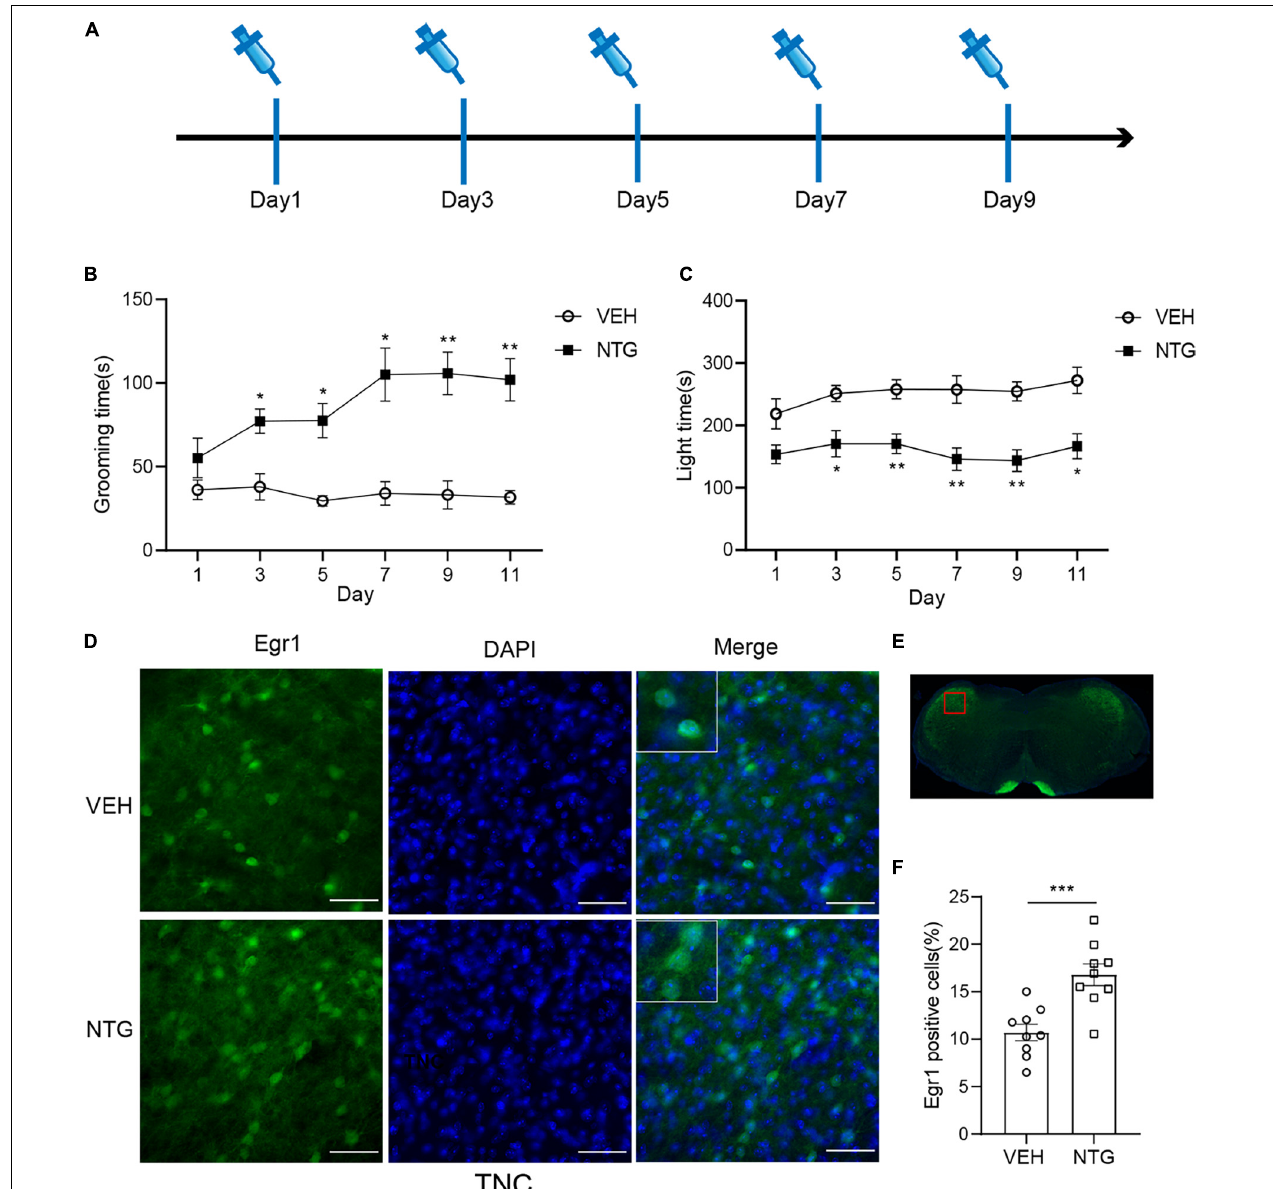
FIGURE 1 | Repeated NTG injection induced migraine related behaviors and elevation of Egr1 expression in TNC (A) Drug (NTG/vehicle) administration schedule. (B) Head grooming time increased in NTG-injected mice as compared to the control group. (C) Chronic injection of NTG decreased time in light chamber in light aversion assay. Two-way ANOVA followed by post-hoc Sidak’s multiple comparison test. (D,F) TNC showed significant increase of the number of Egr1 positive cells after CM. (E) Schematic representation of the analyzed area. Student’s t -test. n = 8/group for behavior test and n = 3/group for the immunofluorescence. * p < 0.05, ** p < 0.01, *** p < 0.001 compared with vehicle. Scale bars = 50 µ m. Egr1, early growth response protein 1; TNC, trigeminal nucleus caudalis.